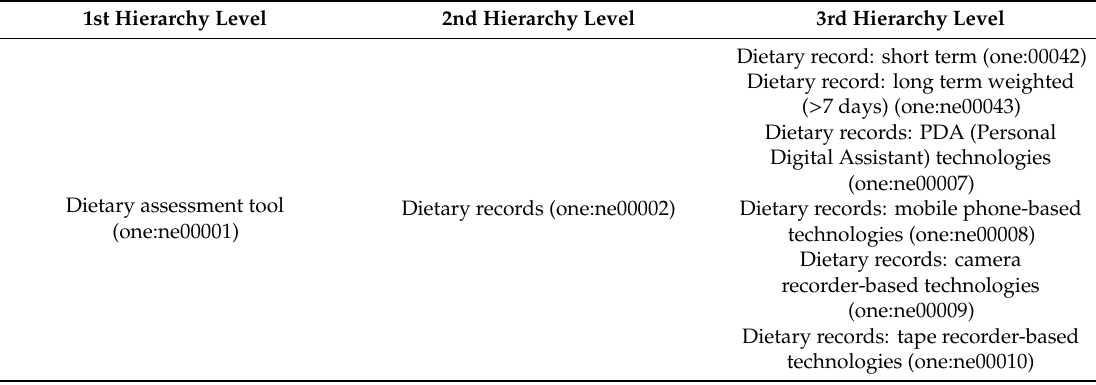
Table 2. Hierarchical structure of nutritional epidemiologic